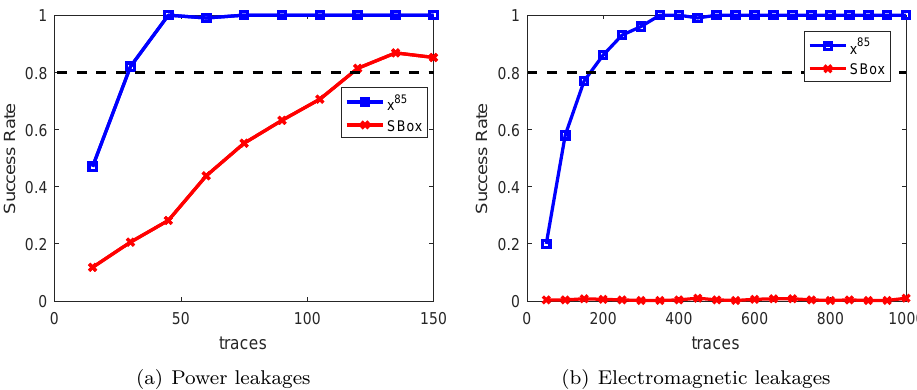
Figure 15: The success rate of deep learning based profiling attacks on practical